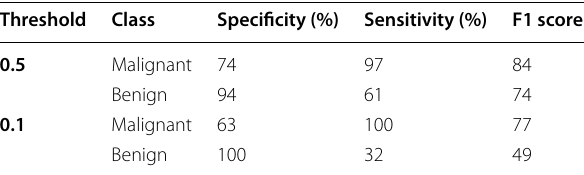
Table 4 Table containing computed metrics (sensitivity, specificity and F1 score) obtained from validation data with gradient boosting models with decision threshold of 0.5 or 0.1